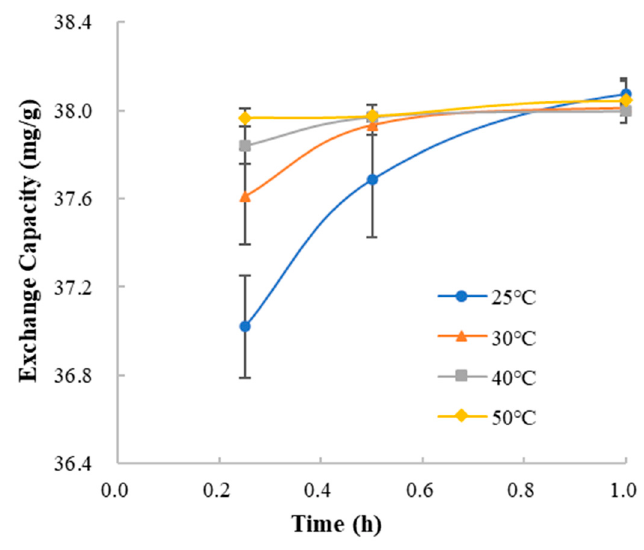
Figure 14. The curves of the exchange capacity vs. mixing time at different temperatures.